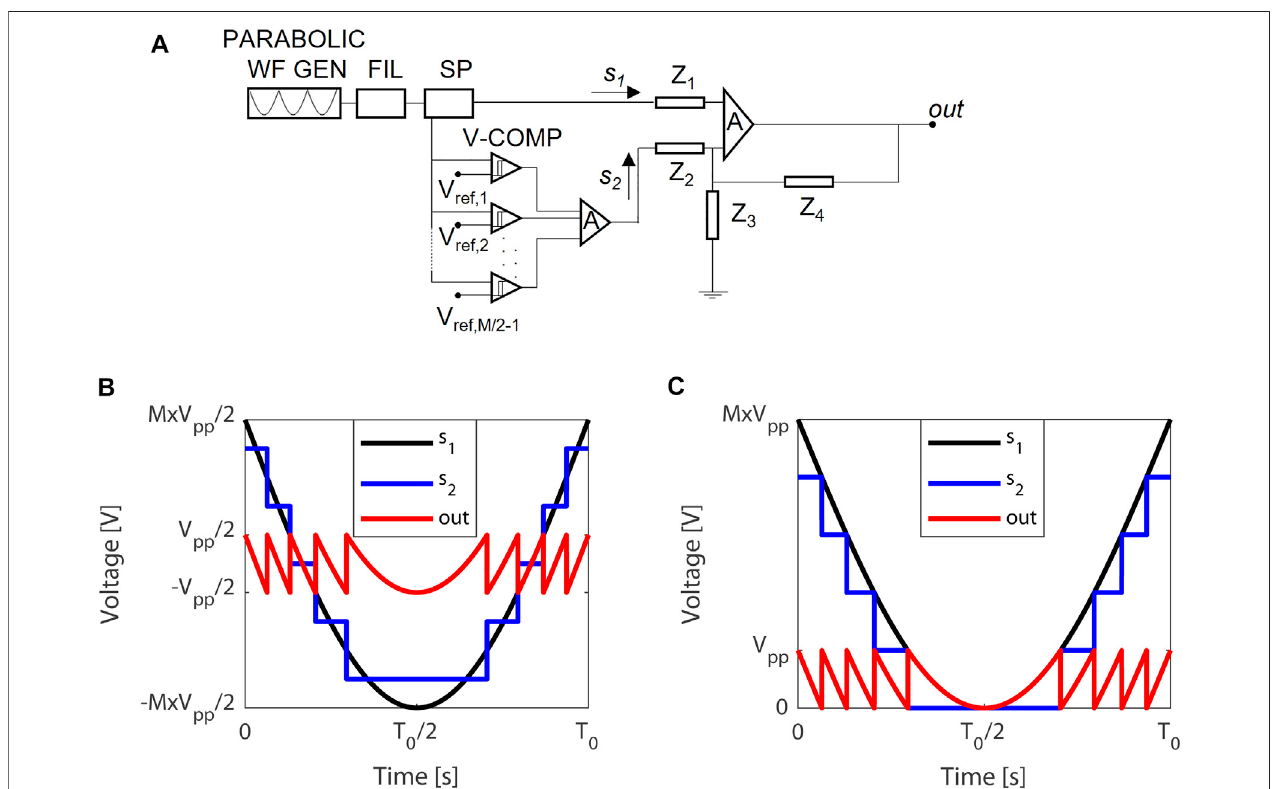
FIGURE 3 | (A) Splitting parabolic signal generator; (B) non-return-to-zero (NRZ) chirped parabolic signal; (C) return-to-zero (RZ) chirped parabolic signal (PARABOLIC WF GEN: parabolic waveform generator; FIL: fi lter; SP: splitter; V-COMP: voltage comparator; Z i ( i = 1 – 4): impedance).